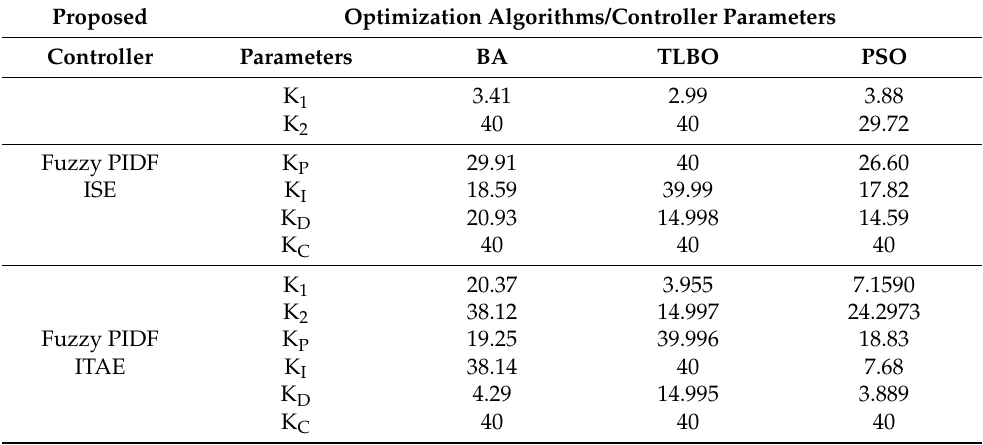
Table 11. Optimal gains of Fuzzy PIDF with different algorithms for GB power system.